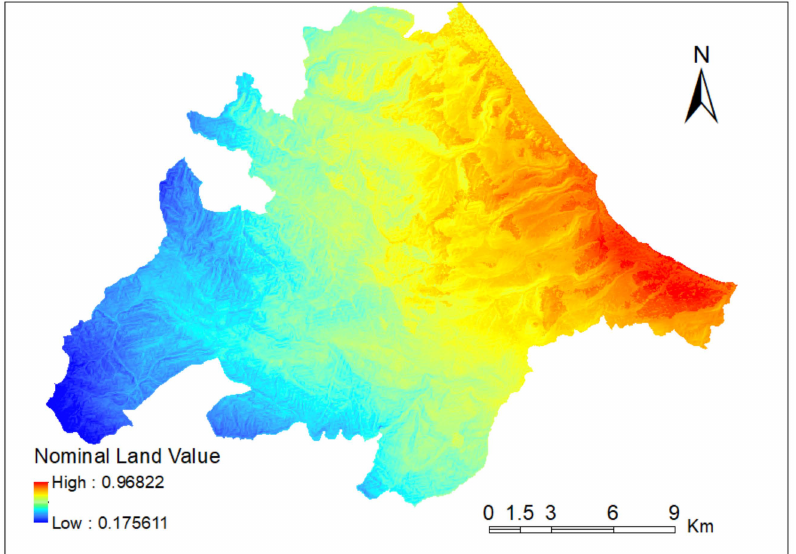
Figure 5. Nominal land value